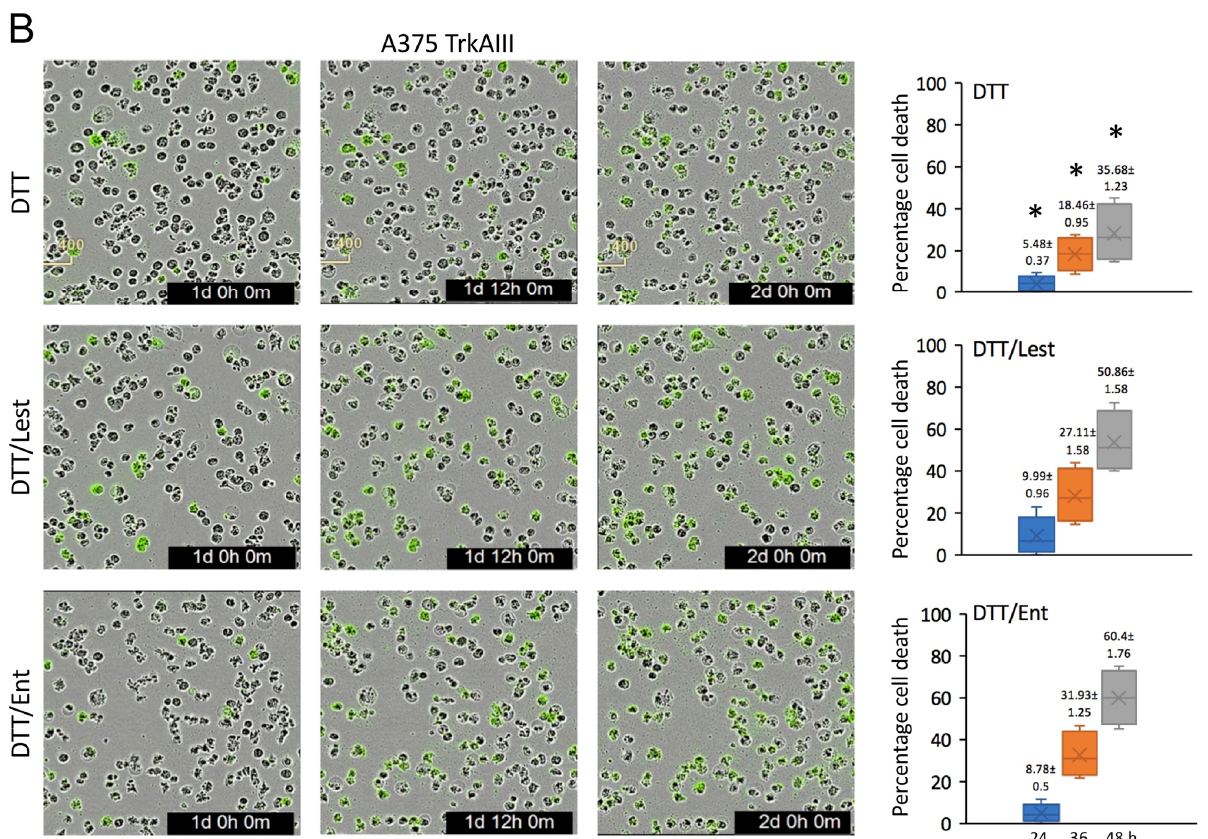
Figure 6. Resistance to DTT-induced death in A375 cells conferred by TrkAIII is prevented by lestaurtinib and entrectinib. Phase contrast micrographs demonstrating enhanced nuclear green dye uptake in fully spliced TrkA ( A ) compared to TrkAIII ( B ) A375 transfectants, following DTT treatment (5 mM) for 24, 36 and 48 h, and the re-sensitisation of TrkAIII but not fully spliced TrkA A375 transfectants to DTT-induced nuclear Incucyte Green Dye uptake in the presence of lestaurtinib (100 nM) and entrectinib (100 nM). Box plots demonstrate these changes as significant (*) reductions in DTT-induced death in TrkAIII A375 transfectants at 24, 36 and 48 h compared to fully spliced TrkA A375 transfectants, in the absence (DTT) but not presence of 100 nM lestaurtinib (DTT/Lest) or 100 nM entrectinib (DTT/Ent). Results are expressed as mean ± s.e. percentage cell death in 3 independent experiments, performed in duplicate.